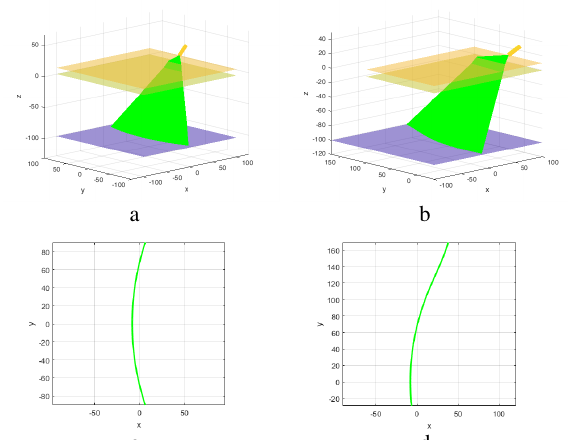
Figure 1: Deformation of a laser light-sheet penetrating from air through glass into water (a,b) and their appearance on a planar surface (c, d). Rotated around the y-axis with 45° (a-d) and additionally around the x-axis with 30° (only b,